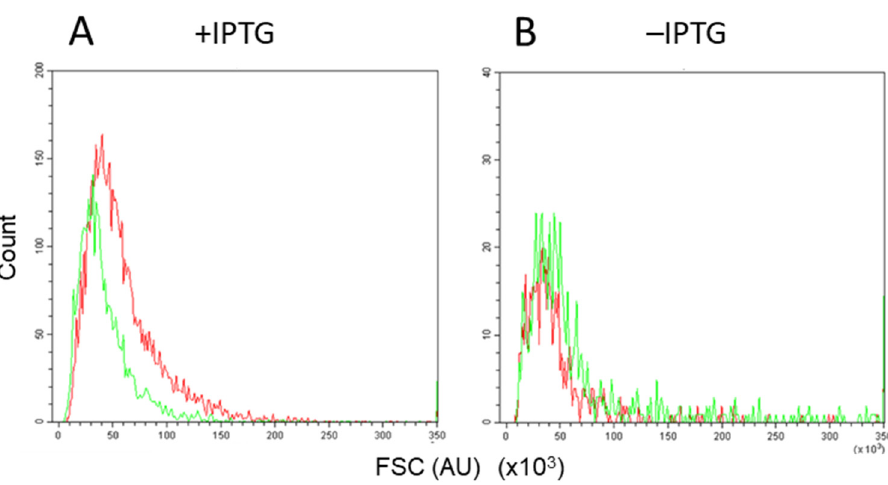
Figure 6. Distribution of particle size (FSC value) of events in the UR quadrants in the presence ( A ) and absence ( B ) of IPTG. The green and red lines are distributions with and without brief sonication, respectively. The experiments were repeated three times with similar results, and one set of representative plots is shown.